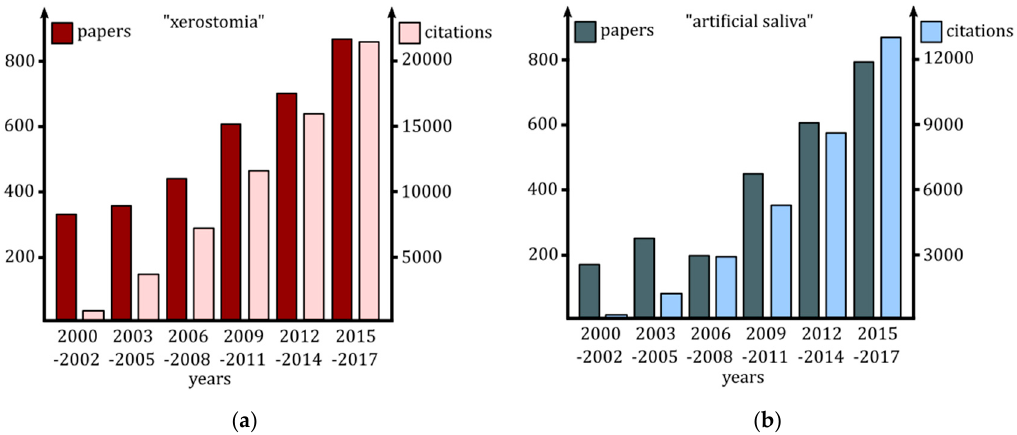
Figure 1. A number of articles and citations regarding the terms: ( a ) “xerostomia”, ( b ) “artificial saliva” according to the Web of Science database.